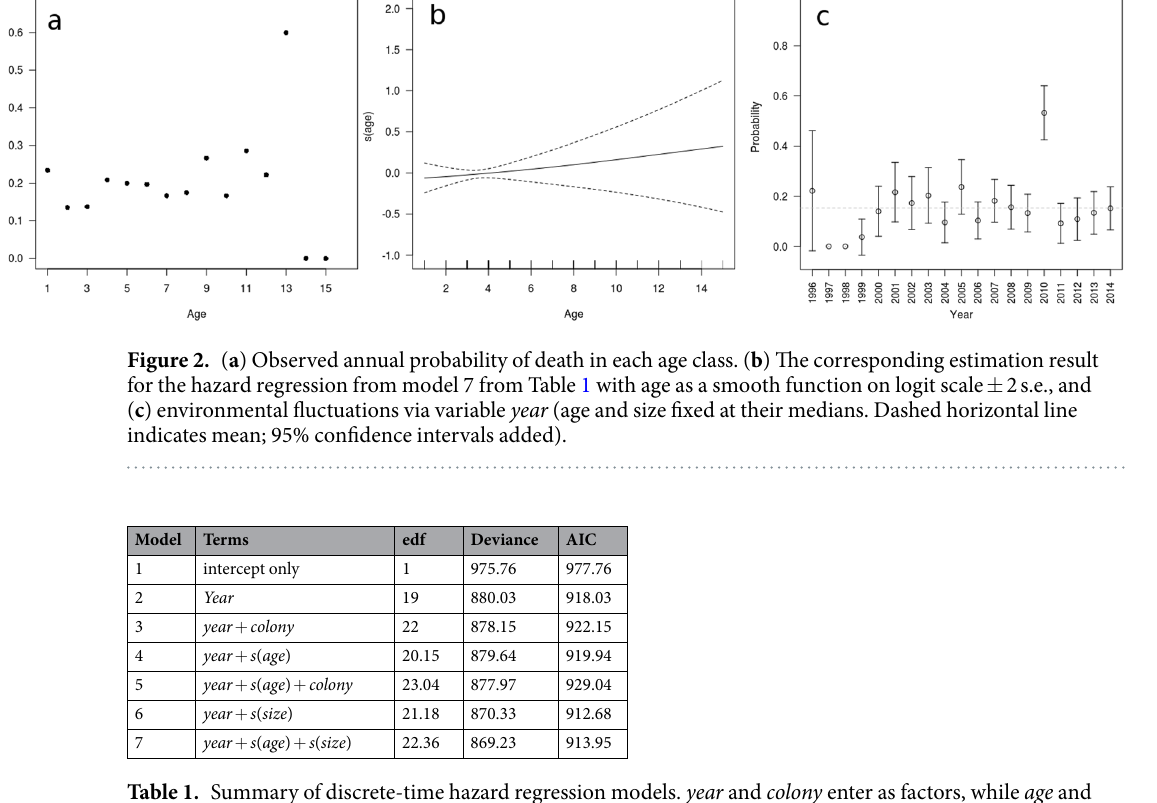
Table 1. Summary of discrete-time hazard regression models. year and colony enter as factors, while age and size are modelled as smooth functions. The last three columns give the effective degrees of freedom (edf) for the model, the deviance, and the resulting AIC,